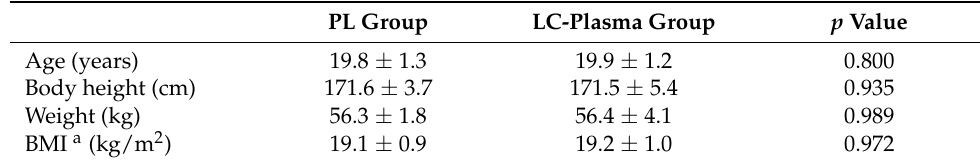
Figure 2. Workflow from participant enrolment to analysis. Figure 2. Work fl ow from participant enrolment to analysis. Table 1. Participants’ characteristics. Table 1. Participants’